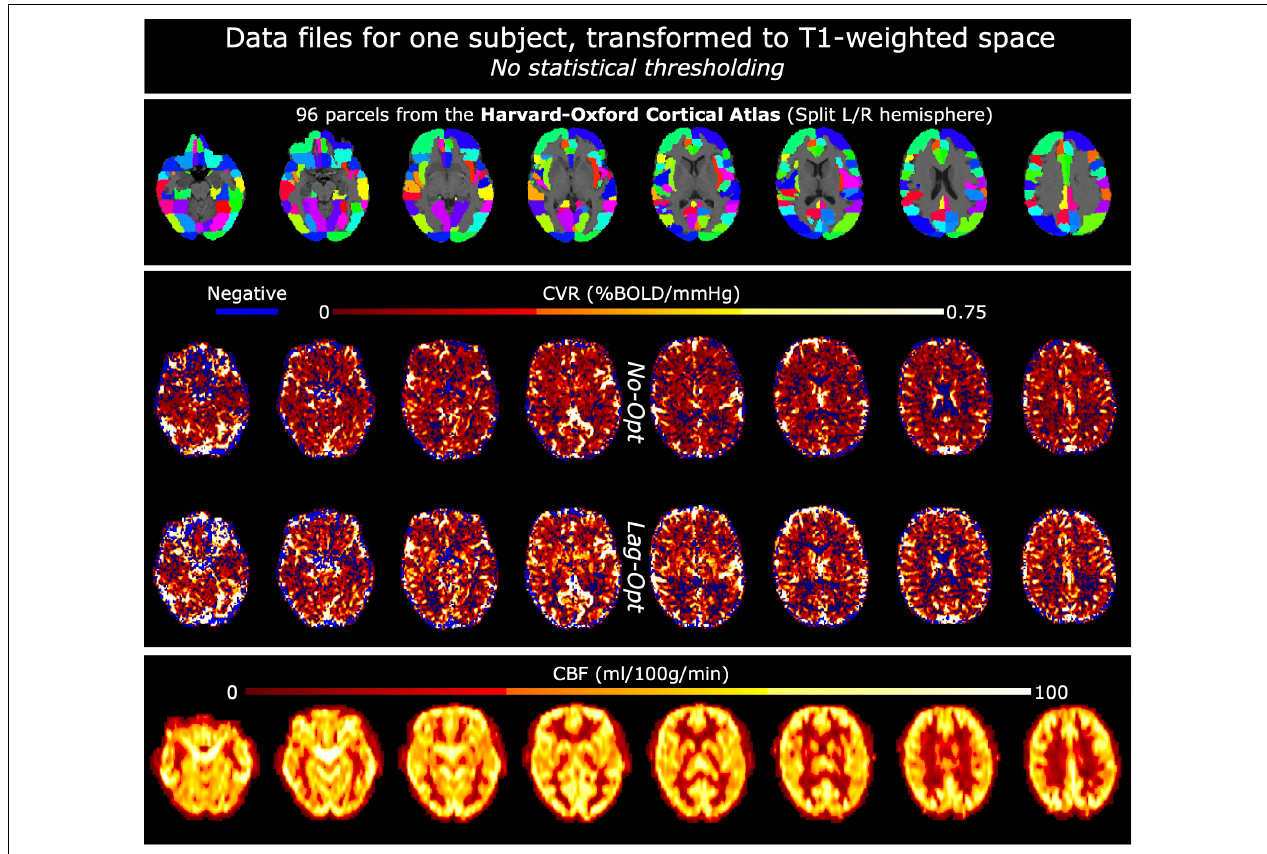
FIGURE 2 | Example data files for one subject, in T1-weighted space. Top panel shows the Harvard-Oxford Cortical atlas: the initial 48 parcels were split into left and right hemisphere parcels making a total of 96. The middle panel shows CVR maps, not optimized for lag (No-Opt) and optimized for lag (Lag-Opt), for the BH + REST data segment. The bottom panel shows baseline cerebral blood flow (bCBF)